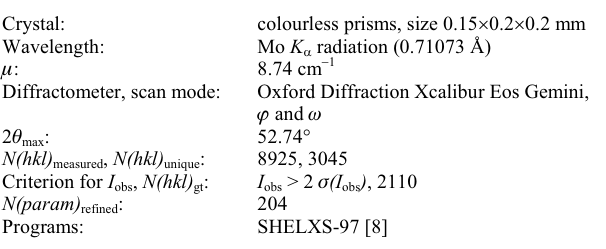
Table 1. Data collection and handling.